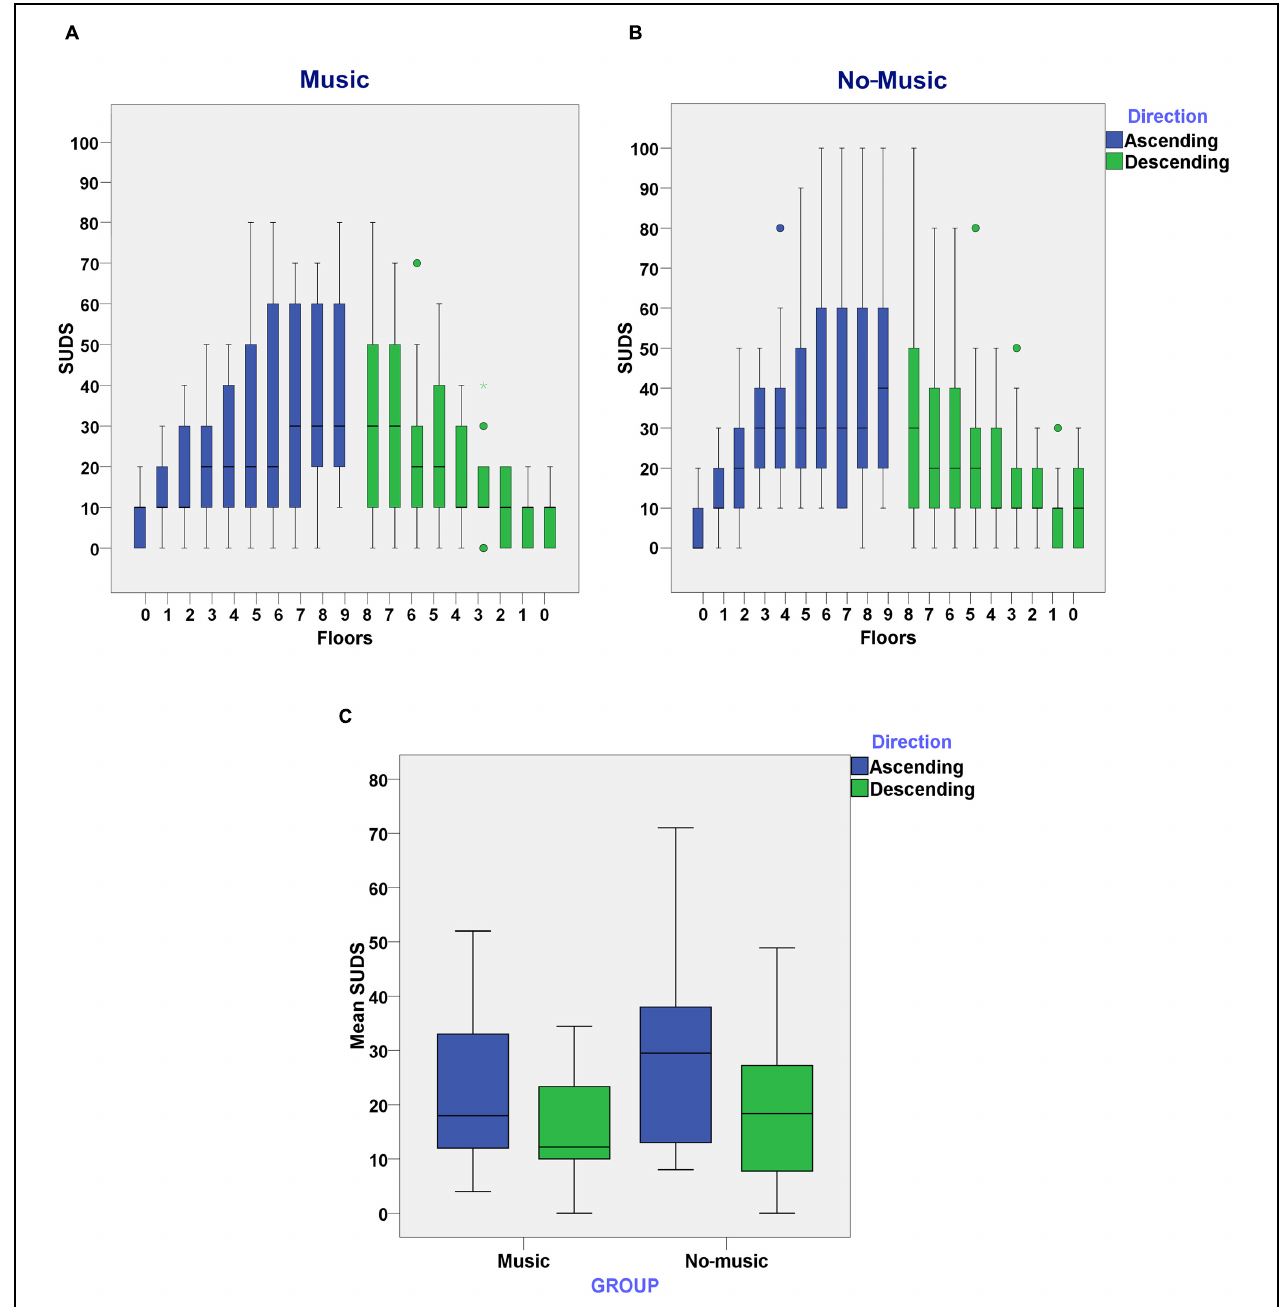
FIGURE 3 | (A) Subjective Units of Discomfort Scores (SUDS) reported on each floor in the music condition while subjects ascended and descended in the elevator; (B) SUDS reported on each floor in the no-music condition while subjects ascended and descended in the elevator; (C) Mean of SUDS reported as subjects ascended or descended through the elevator in the music and no-music